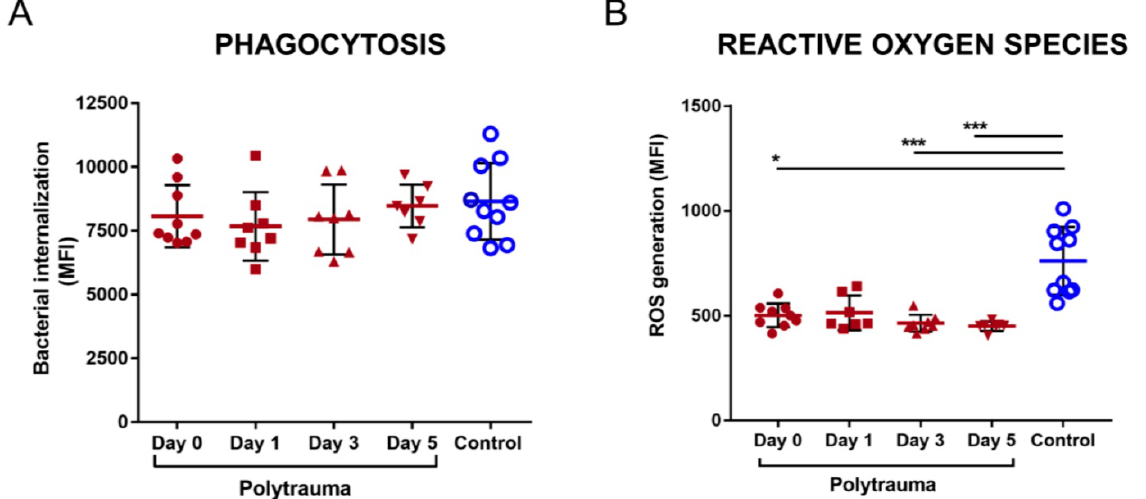
Figure 1: Effects of polytrauma patient sera on bacterial phagocytosis and generation of reactive oxygen species (ROS) by neutrophil-like cells. Differentiated PLB-985 cells (dPLB) were pre-treated with cell culture medium containing post-trauma sera or control sera (w/v=10%) for 4h prior to exposure to further stimulation, as further described: A) Phagocytosis was triggered by incubation with pHrodo Green-labelled S. aureus BioParticles for 2h. Internalization and acidification of the fluorophore in phagosomes results in the generation of a fluorescent signal; B) Oxidative burst was measured in dPLB cells by assessing generation of superoxide anions induced by stimulation with 100nM fMLP for 5 min, together with CellROX reagent for a further 30 min incubation. Both assays were quantified using flow cytometric analysis. (Kruskal-Wallis test, Dunn’s Multiple Comparison Test, *p<0.05,